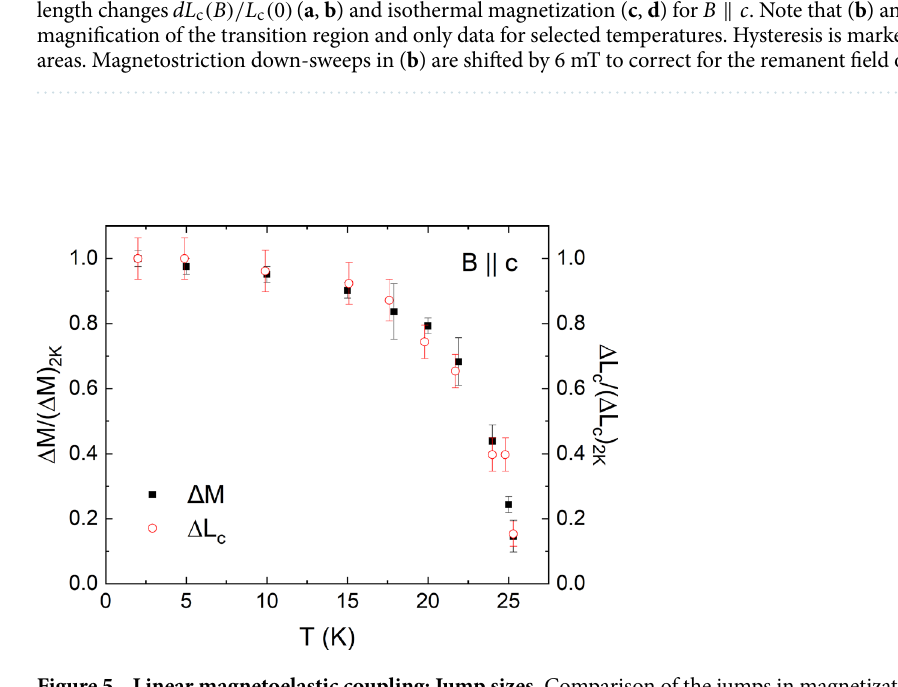
Figure 5. Linear magnetoelastic coupling: Jump sizes. Comparison of the jumps in magnetization (left ordinate) and relative length changes (right ordinate) at the metamagnetic transition normalized by their value at 2